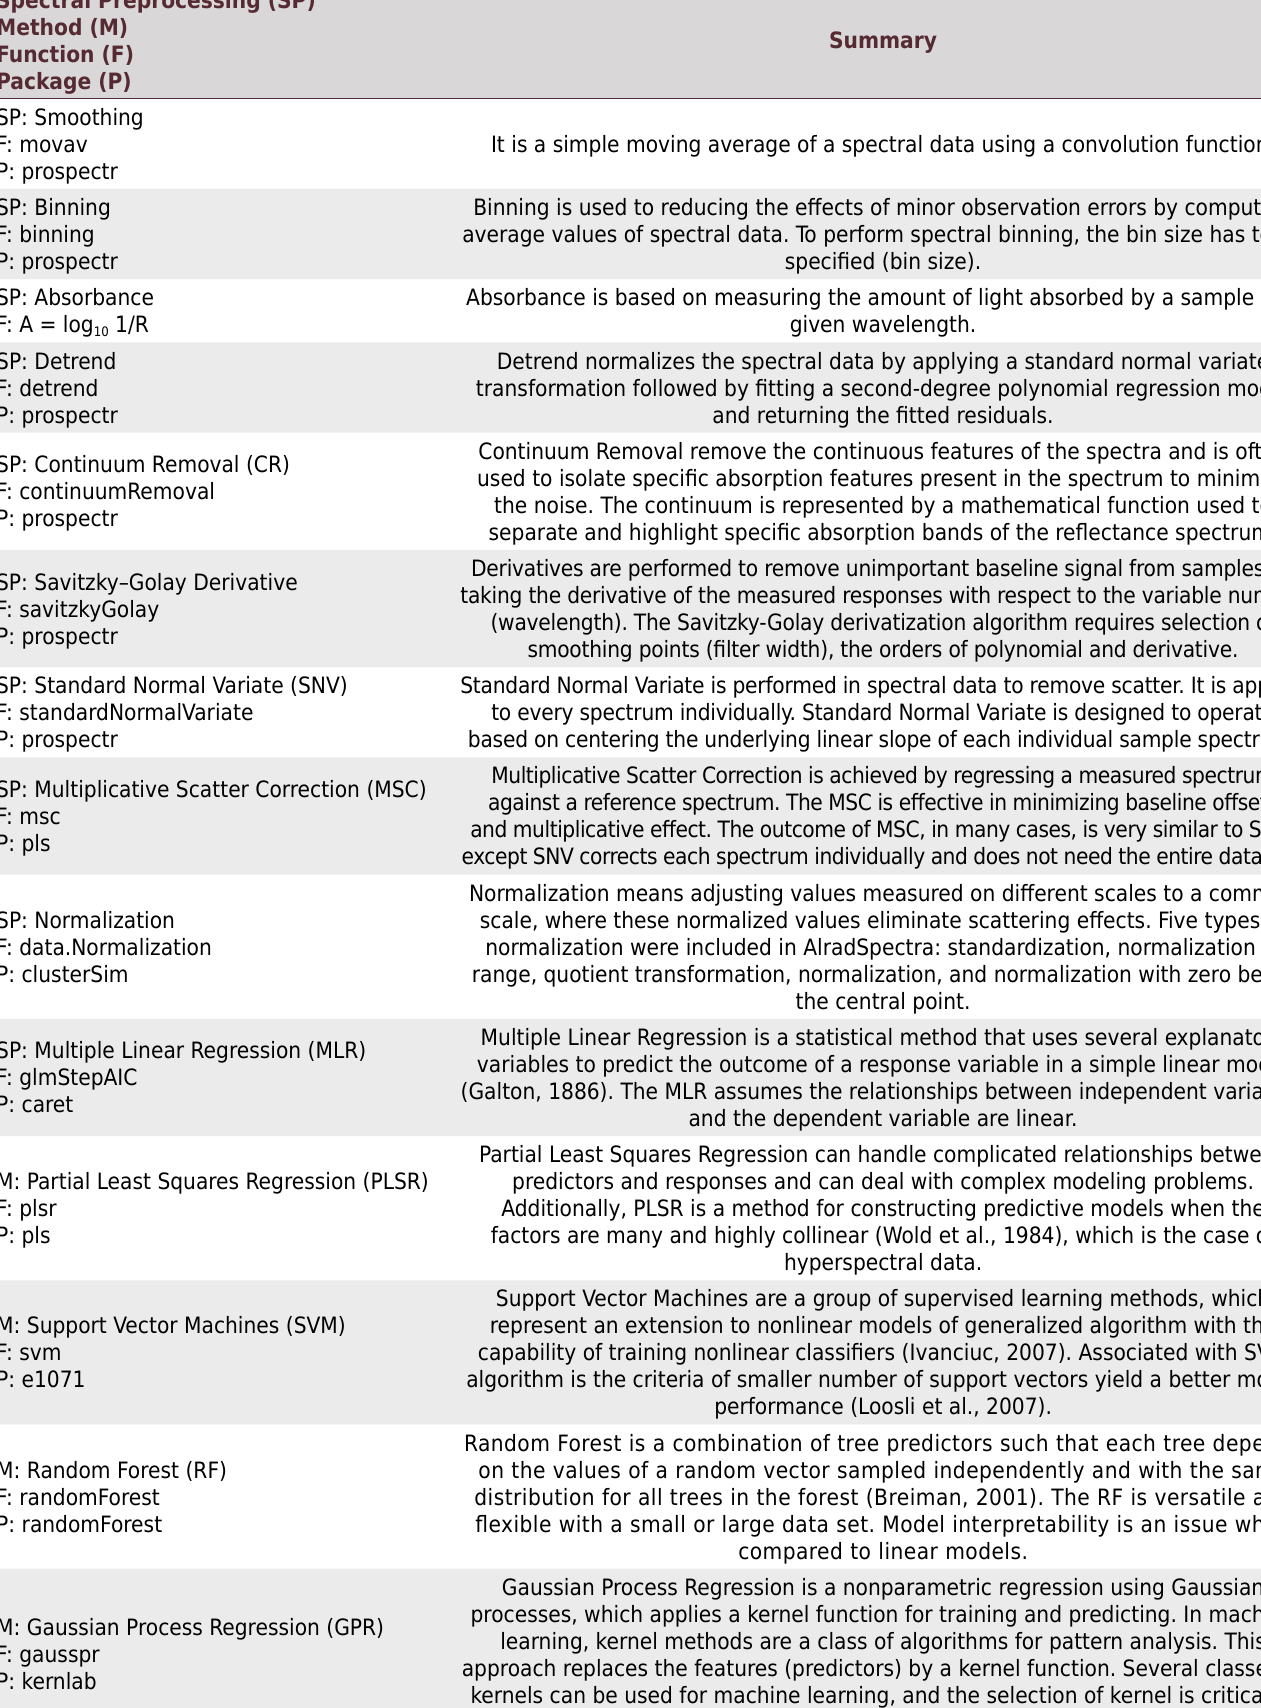
Table 2. Spectral preprocessing and methods with the respective function and R package implemented in the AlradSpectra Spectral Preprocessing (SP) Method